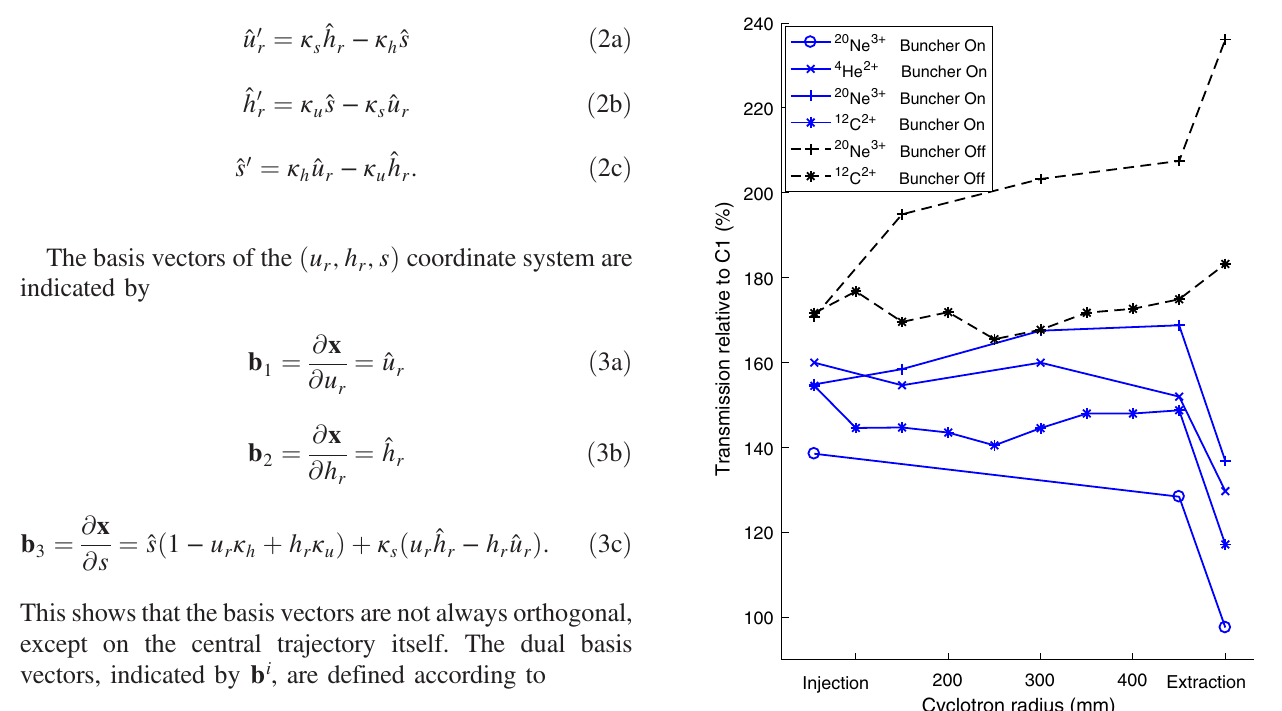
FIG. 4. Experimental transmission through SPC2 when using the vertically focusing C2-inflector, as a percentage of the standard C1-inflector transmission. Solid lines are with the buncher and dotted lines are without the